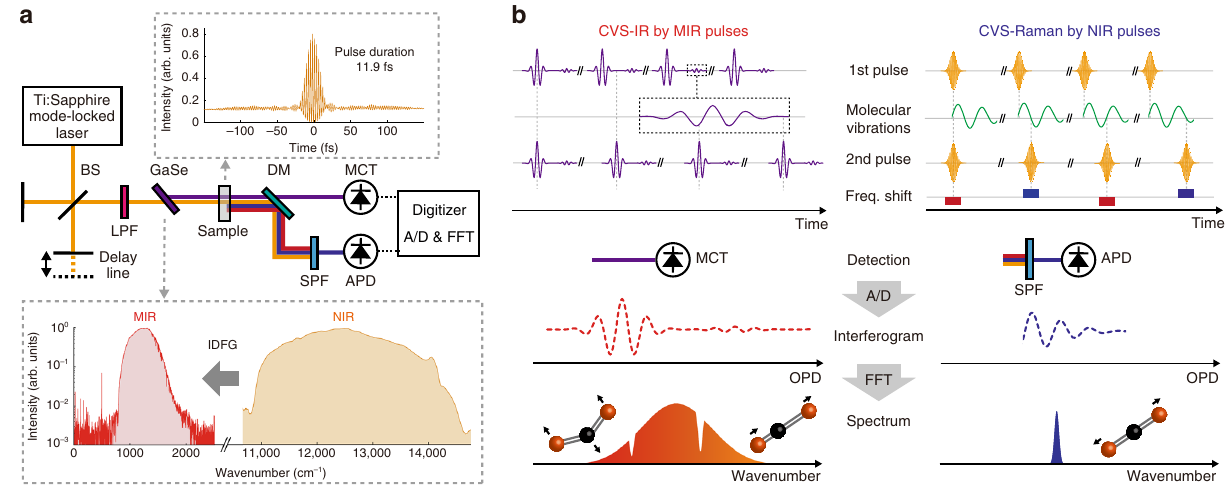
Fig. 1 Schematic and concept of CVS. a Schematic of CVS. The insets show the autocorrelation trace of the NIR pulses and the spectra of NIR and MIR pulses. BS: Beamsplitter, LPF: Long-pass fi lter, DM: Dichroic mirror, SPF: Short-pass fi lter, MCT: HgCdTe, APD: Avalanche photodetector. b Conceptual description of CVS. The fi gure shows a linear triatomic molecule as an example of molecular vibrations. The left panel displays CVS-IR process given by MIR pulses, while the right panel CVS-Raman process by NIR pulses. OPD: Optical path length